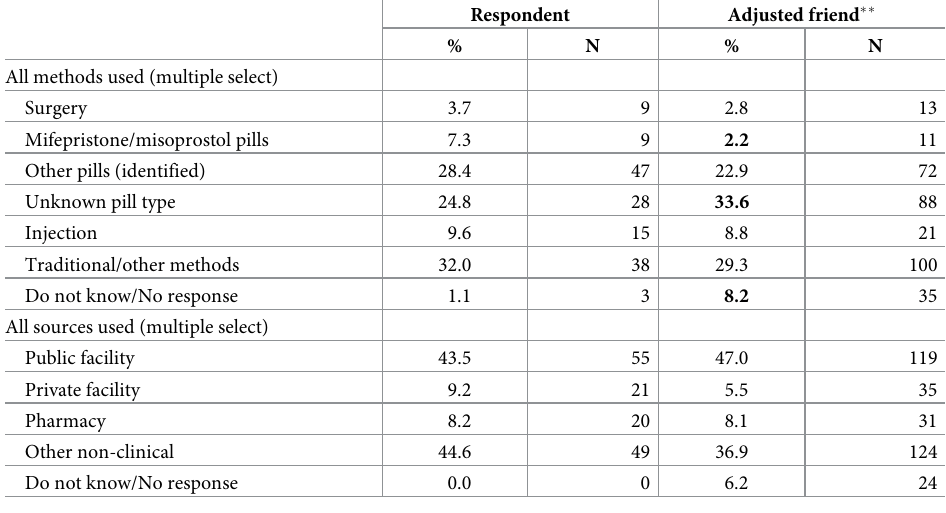
� Estimates weighted, Ns unweighted; bold indicates p-value for design-based F-test (reference respondents) less than 0.05 �� Estimates include respondent abortion characteristics in place of "missing" friends if respondent reported 0 friends